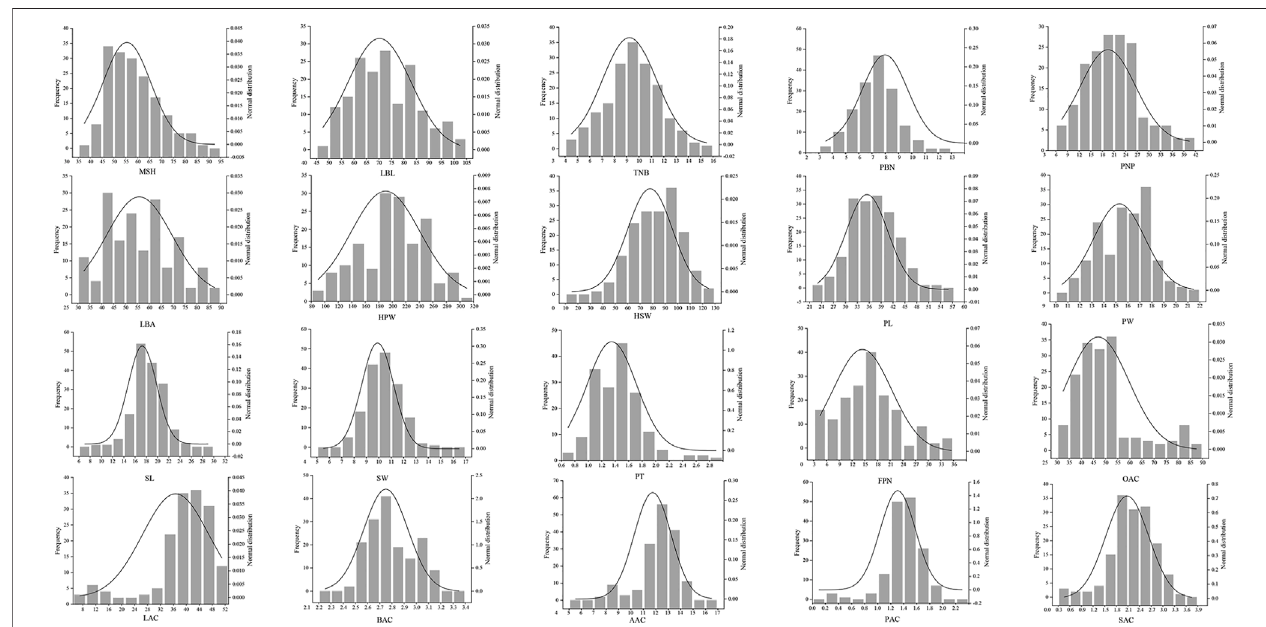
FIGURE 1 | Frequency distribution of 178 peanut cultivars for 20 traits. MSH, main stem height; LBL, lateral branch length; TNB, total number of branches; PBN, pod-bearing branches number; PNP, pod number per plant; LBA, lateral branch angle; HPW, hundred pod weight; HSW, hundred seed weight; PL, pod length; PW, pod width; SL, seed length; SW, seed width; PT, peel thickness; FPN, fi lled pods number; OAC, oleic acid content; LAC, linoleic acid content; BAC, behenic acid content; AAC, arachidic acid content; PAC, palmitic acid content; SAC, stearic acid content.